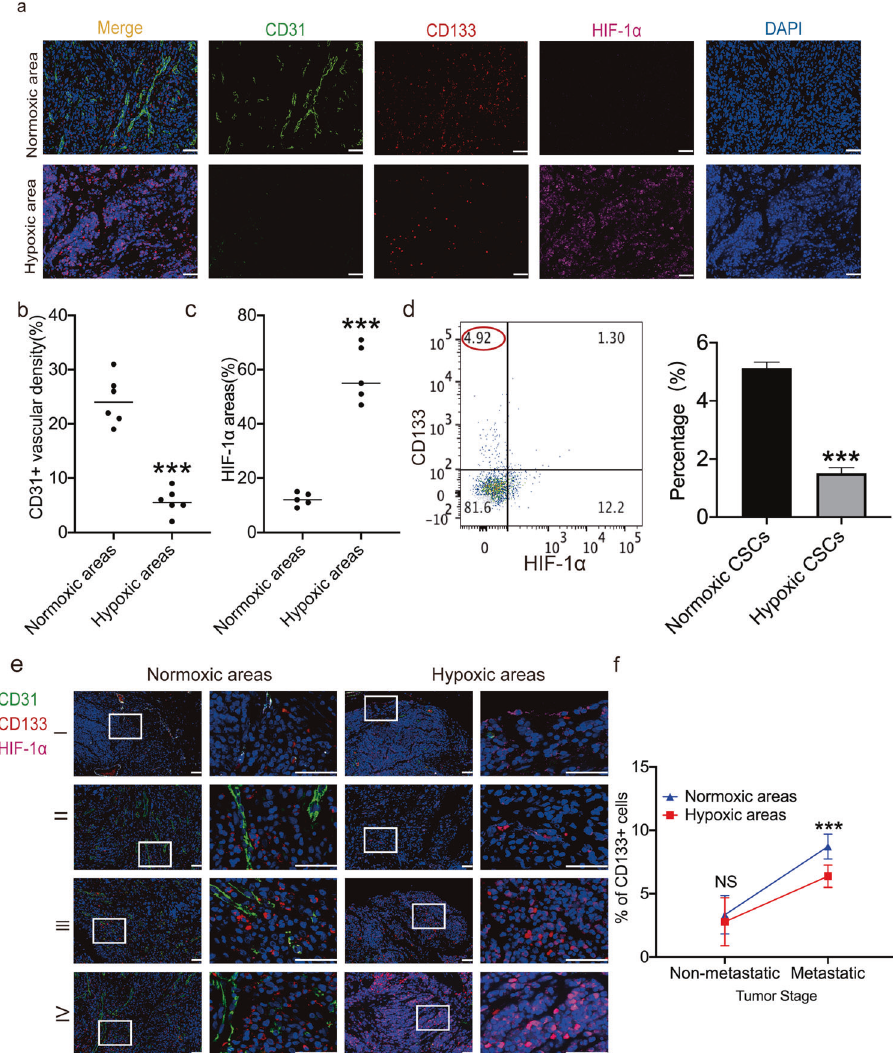
Fig. 1 Abundance of normoxic CSCs is positively related to tumor stage of patients with CRC. a Representative immuno fl uorescence staining images of normoxic and hypoxic areas in primary CRC tumors. Scale bar: 50 μ m. b Quanti fi cation of vessel density in normoxic and hypoxic areas in primary CRC tumors ( n = 6). c Quanti fi cation of ratios of HIF-1 α + tumor cells in normoxic and hypoxic areas in primary CRC tumors ( n = 5). d Abundance of normoxic (i.e.CD133 + HIF-1 α − ) and hypoxic CSCs (i.e. CD133 + HIF-1 α + ) in primary CRC tumors by FACS analysis ( n = 5). Experiments were repeated three times independently. e Representative immuno fl uorescence staining images in primary CRC tumors at different stages (i.e. TNM stage I ( n = 9), II ( n = 12), III ( n = 10), IV ( n = 21)). Scale bar: 50 μ m. f Quanti fi cation analysis of abundance of CD133 + cells in normoxic and hypoxic areas in primary CRC tumors at non-metastatic (Stages I, II, III ( n = 31)) versus metastatic (Stage IV ( n = 21)) stages. Data are expressed as mean ± SD. * P < 0.05, ** P < 0.01, *** P <